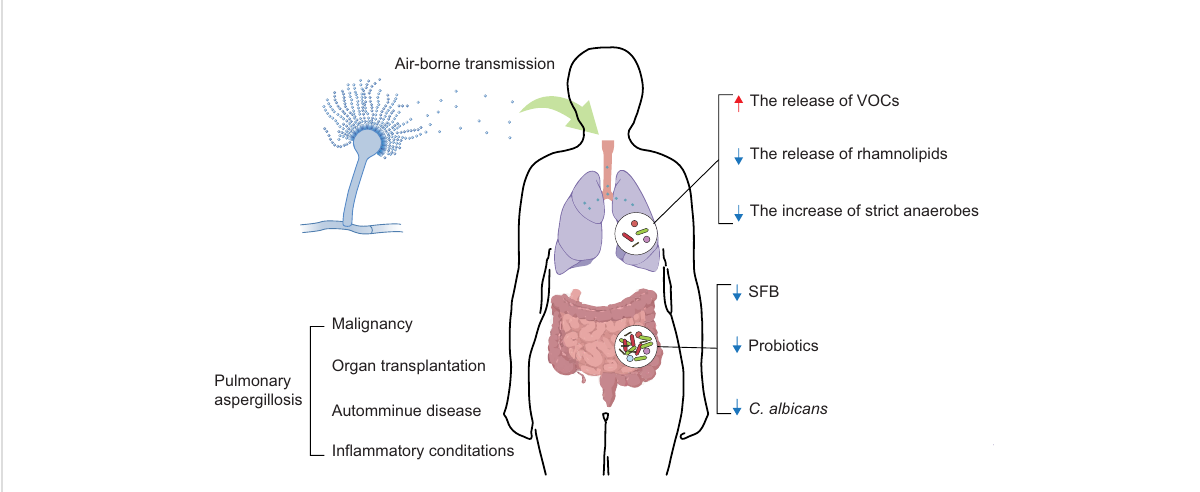
FIGURE 1 Interaction between the microbiome and PA. Aspergillus spp. conidia usually enter the human body through air-borne transmission. The colonization and infection of Aspergillus spp. have dramatically increased, considering the growing numbers of patients with an impaired immune state associated with the treatment of malignancy, organ transplantation, autoimmune diseases, and in fl ammatory conditions (4, 5). The development of PA is in fl uenced by composition and metabolites of the lung and gut microbiomes (e.g., VOCs, rhamnolipids, strict anaerobes, SFB, probiotics, C. albicans ). ↑ : increase; ↓ :